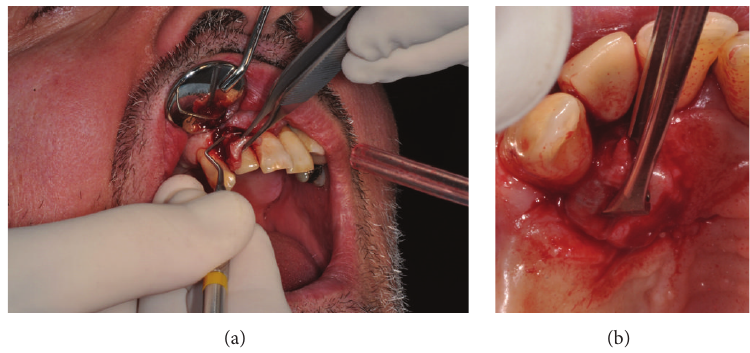
Figure 4: (a, b) Vestibular and palatal excisional biopsy of the lesion.